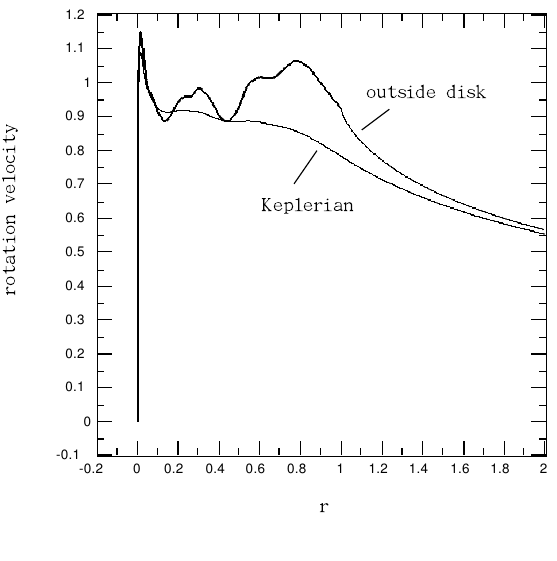
Figure 8. Profiles of the Milky Way rotation curves of the originally measured one (with imposed V (0) = 0 , thick line) and its extension outside the disk edge at r = 1 (the thin ( r ) according to Keplerian formula Equation (27) based on the line as labeled), as well as V K mass density, ρ ( r ) , shown in Figure 3 (the thin line as